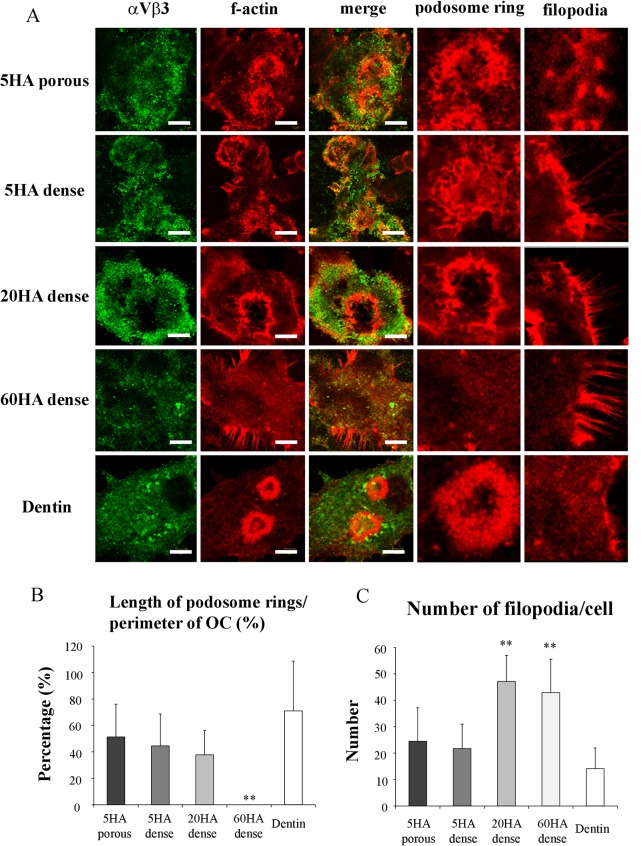
Formation of podosome rings in osteoclasts cultured on BCPs.(A) Cells were labeled for nuclei (blue), f-actin (red) and αVβ3 integrin (green). Bars = 10 μm. Right two columns are pictures of podosome rings or filopodia in high magnification. (B) Percentage of covered with podosome rings in perimeter of osteoclasts cultured on BCPs. Data are expressed as the mean ± S.D. n = 6–8. **p<0.01 significant difference from dentin (control). (C) Number of filopodia of osteoclasts cultured on BCPs. Data are expressed as the mean ± S.D. n = 6–8. **p<0.01 significant difference from dentin (control).